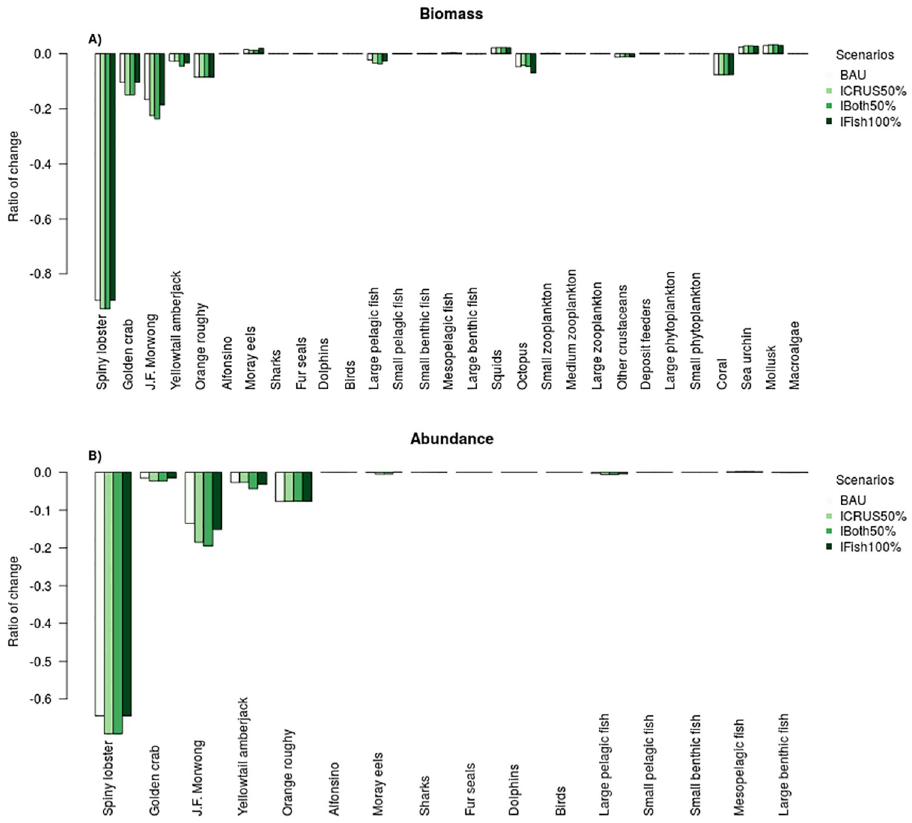
Fig 7. Relative change in biomass (A) and abundance (B) for the business as usual (BAU), a 50% increase in fishing effort of crustaceans (ICRUS50%), 50% increase in fishing effort for crustaceans and finfish (IBoth50%) and 100% increase in fishing effort for finfish (IFish100%). An unfished ecosystem is the base case for comparisons. Note that the y-axes is the ratio of change against the starting conditions—so a -0.5 result indicates a 50% decrease and a 0.5 result indicates a 50% increase